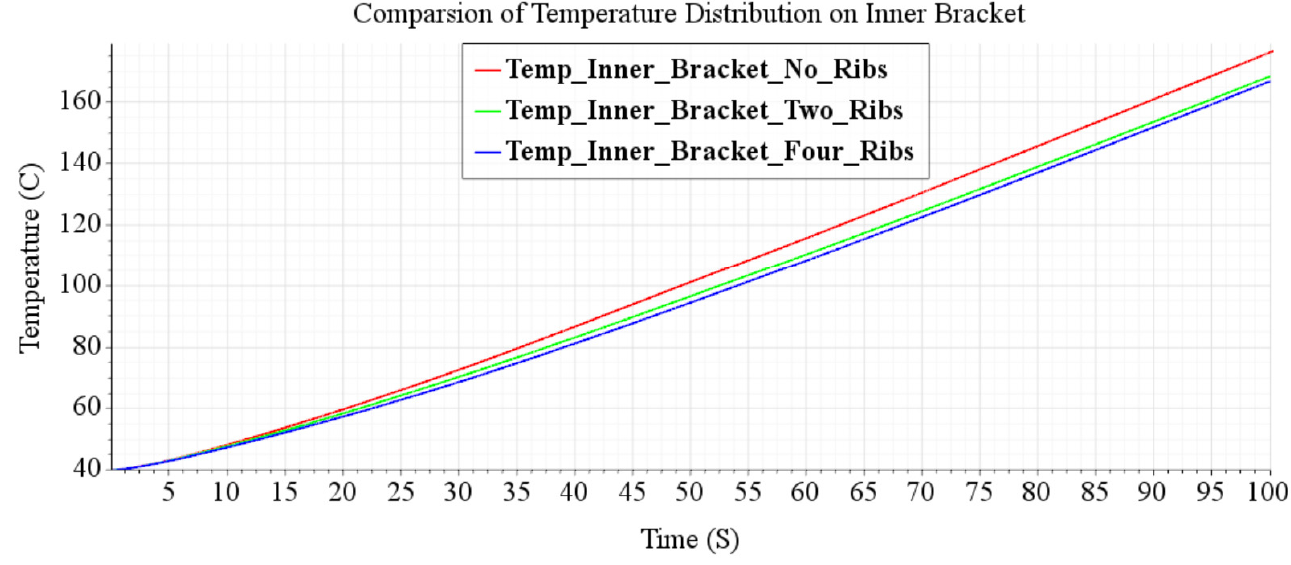
Figure 14. The inner bracket temperature change with function of time for four rib configuration.